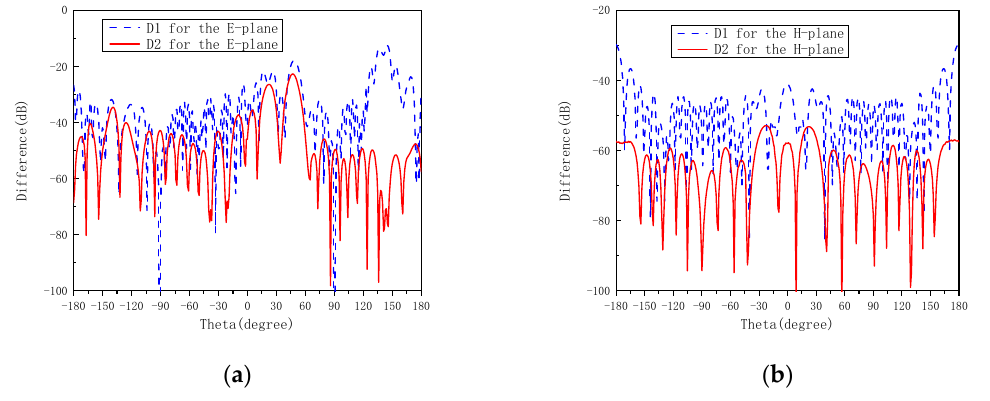
Figure 5. Comparison of the pattern. ( a ) E-plane; ( b ) H-plane.